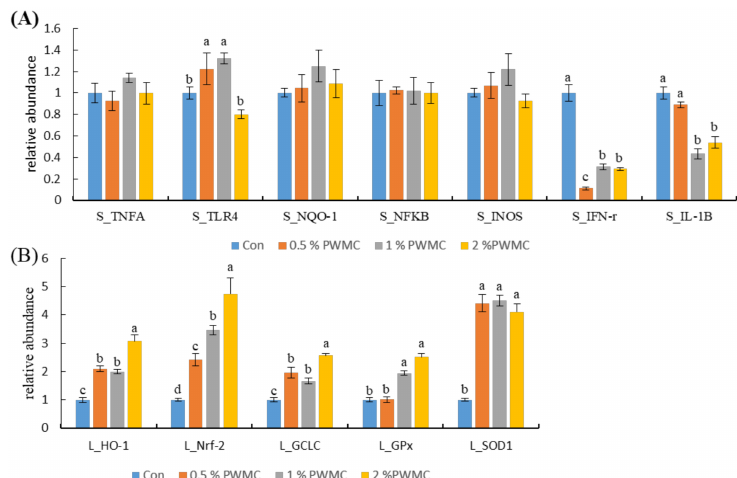
Figure 3. Inflammation- ( A ) and antioxidant-related ( B ) mRNA expression in the spleen (S) and